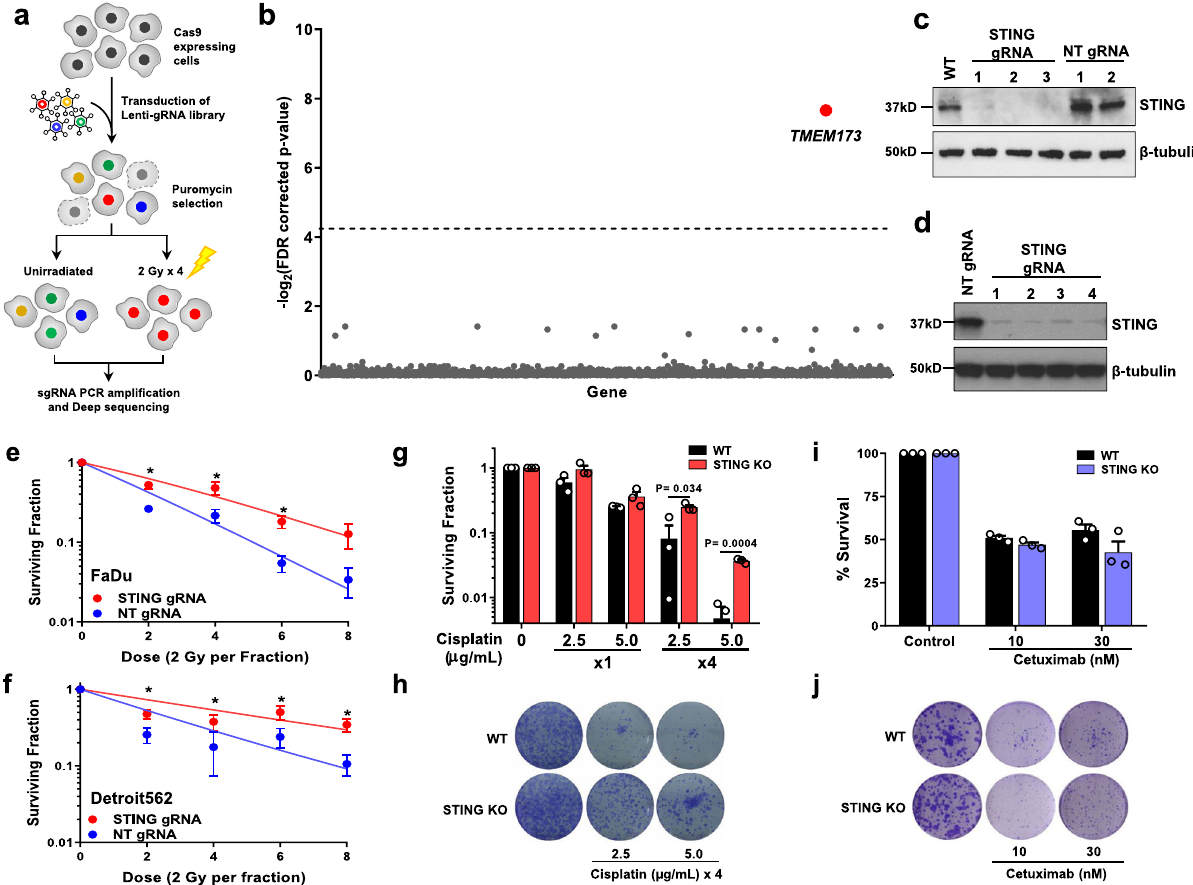
Fig. 1 STING loss confers resistance to DNA-damaging agents. a Schematic of CRISPR-Cas9 screen in FaDu cells aimed at identifying regulators of DNA damage. b Scatter plot showing genes corresponding to gRNAs that were signi fi cantly enriched in irradiated populations ( n = 3 independent experiments) using MAGeCK analysis. c Immunoblot of FaDu isogenic STING knockout cells constructed with three independent STING gRNAs and two non-targeting (NT) gRNAs. Immunoblots are representative of two independent experiments. d Immunoblot of Detroit562 isogenic STING knockdown (dCas9) cells. Clonogenic survival analysis of FaDu STING KO ( e ) or Detroit562 STING silenced ( f ) cells treated with the indicated dose of ionizing radiation (2 Gy per fraction/day). Immunoblots are representative of two independent experiments (NT gRNA 1 and STING gRNA 4) or one independent experiment for STING gRNAs 1 – 3. In e , f error bars represent SEM from three independent experiments. In e P -values for 2, 4, and 6 Gy are 0.0002, 0.0002, and 0.04 as determined by unpaired, two-tailed t -tests without multiple comparison correction. In f P -values for 2, 4, 6, and 8 Gy are 0.03, 0.049, 0.01, and 0.02 as determined by unpaired, two-tailed t -tests without multiple comparison correction. Quanti fi cation ( g ) and representative images ( h ) of clonogenic survival analysis of FaDu WT and STING KO cells treated with Cisplatin as indicated. Error bars represent SEM from three independent experiments. analyzed by unpaired, two-tailed t -tests without multiple comparison correction. Quanti fi cation ( i ) and representative images ( j ) of clonogenic survival analysis of FaDu WT and STING KO cells treated with cetuximab. Error bars represent SEM from three independent